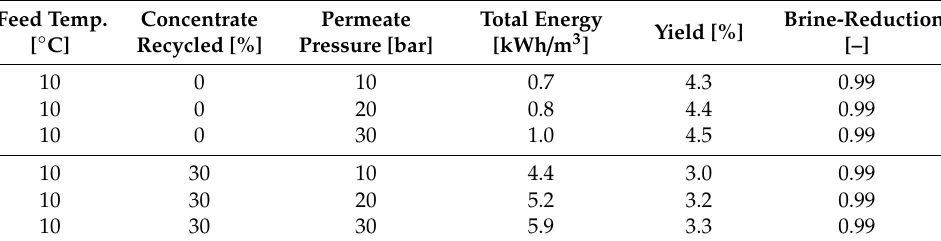
Table 6. Optimized results of SW30XHR-440i membrane at 10 ◦ C.